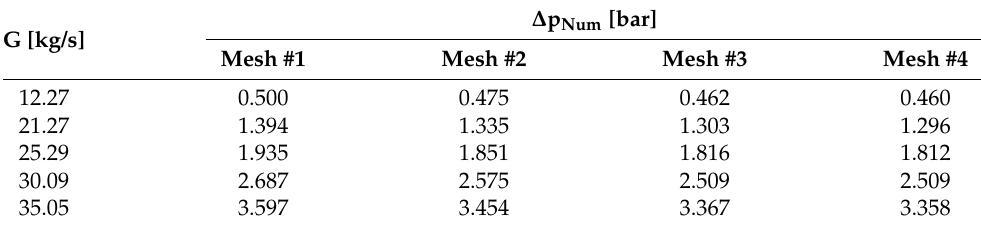
Table 6. Outlook of the results obtained with the different